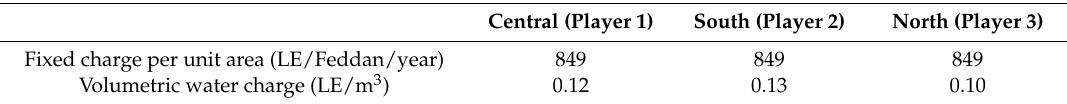
Table 28. Proposed tariff, based on the Shapley Value allocation of the joint